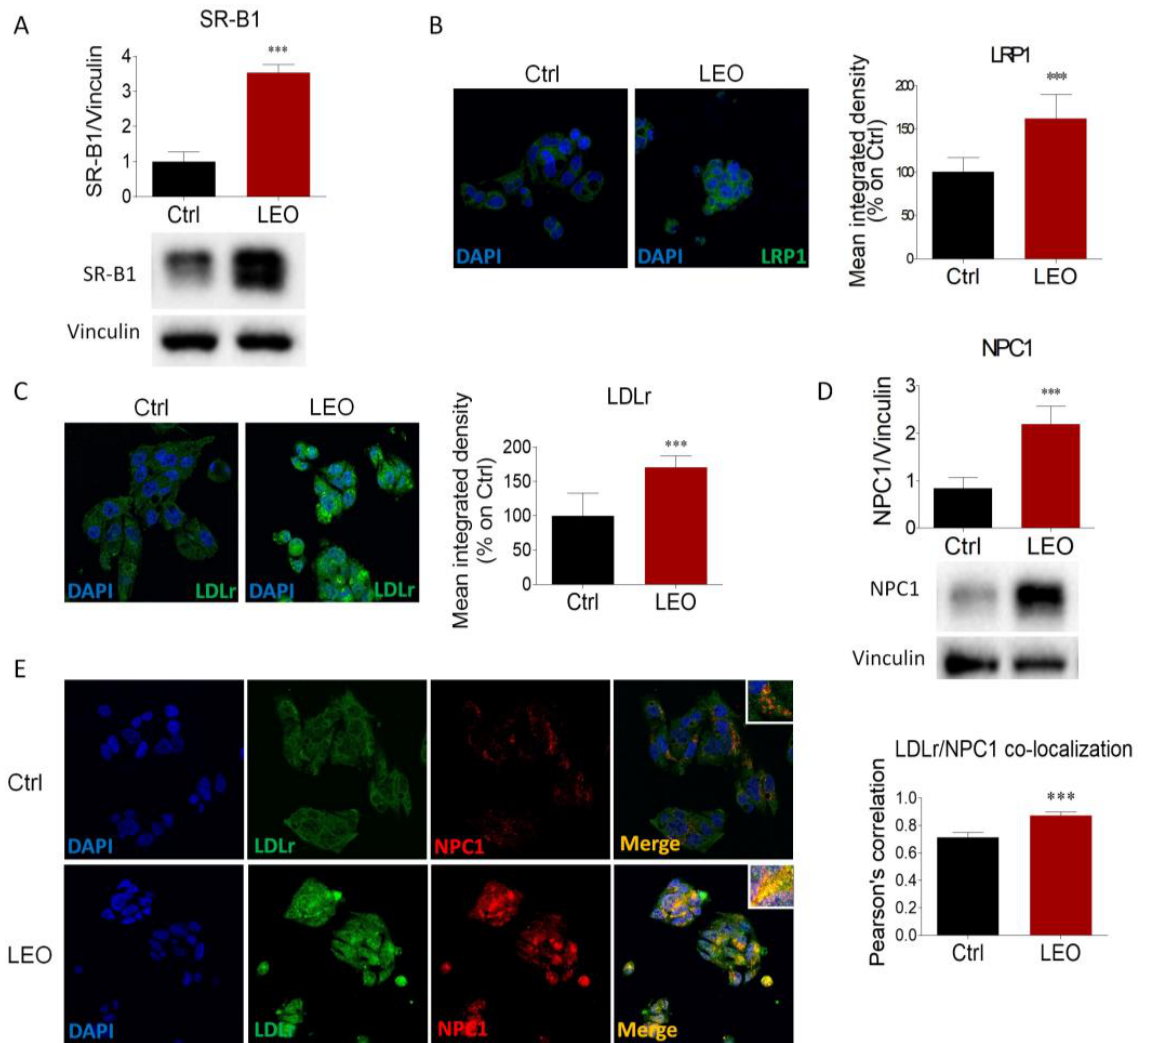
Figure 3. LEO treatment increases the expression of proteins involved in cholesterol uptake and intracellular trafficking in HepG2 cells. ( A ) Representative Western blot and densitometric analysis of SR-B1 in HepG2 cells treated with the vehicle (DMSO, Ctrl cells) and LEO (0.005%) for 24 h. Vinculin was chosen as the loading control. n = 3 independent experiments. Representative immunofluo- rescence and respective quantification of the mean fluorescence intensity of ( B ) LRP1 (green) and ( C ) LDLr (green) in HepG2 cells treated as in (A). DAPI (blue) was used to counterstain cell nuclei. n = 7 independent experiments. ( D ) Representative Western blot and densitometric analysis showing NPC1 expression in HepG2 cells treated as previously described. Vinculin served as the house- keeping protein. n = 4 biological replicates. ( E ) Co-immunofluorescence analysis was performed in HepG2 cells treated as previously reported, by using antibodies against NPC1 (red) and LDLr (green) (left panel). Nuclei were counterstained with DAPI. Pearson’s correlation coefficient r (right panel) was calculated to evaluate the protein co-localization. n = 7 different experiments. Data represent means ± SD. Statistical analysis was assessed using the unpaired Student’s t -test. *** p <